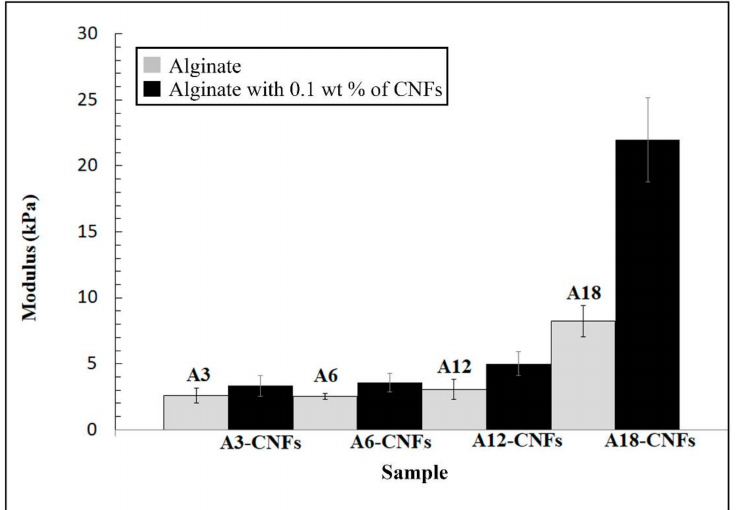
Figure 6. Mechanical compressive modulus (mean ± standard deviation) of alginate hydrogels (grey columns) and alginate composite hydrogels with 0.1% w/w of CNFs (black columns) cross-linked with increasing amounts of calcium chloride (3, 6, 12 and 18% w/w